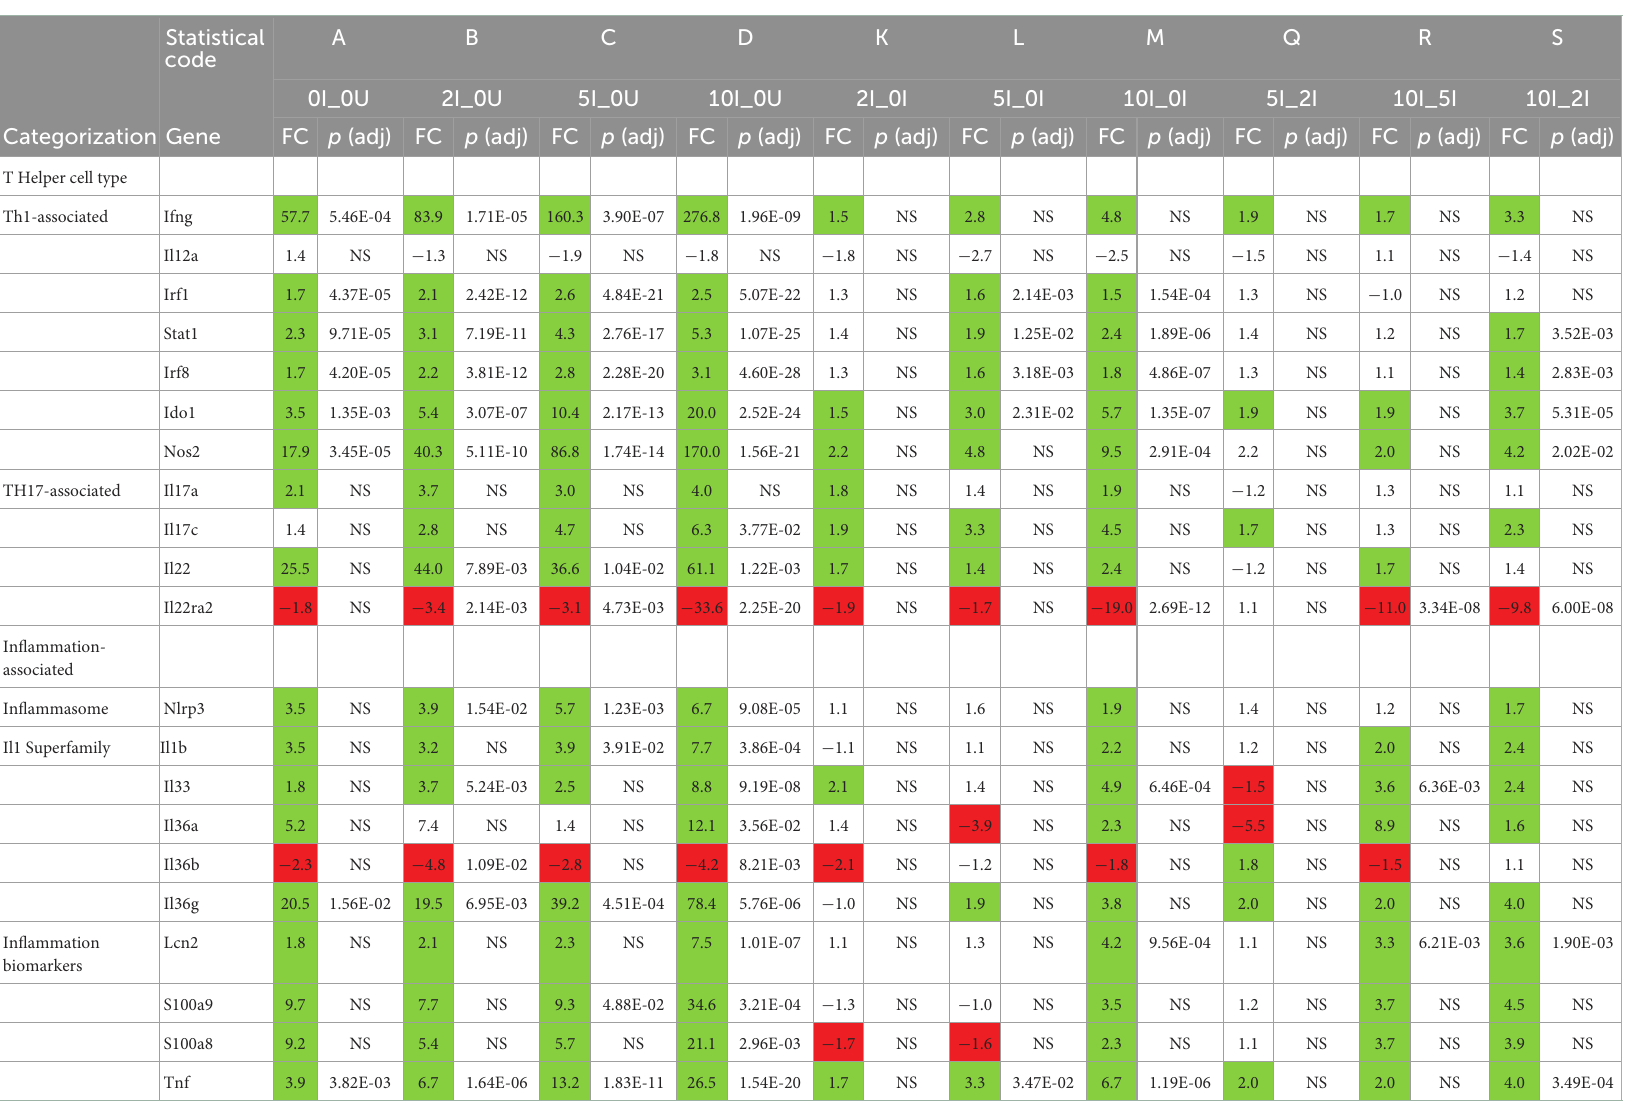
TABLE 5 Selected differentially expressed genes in the